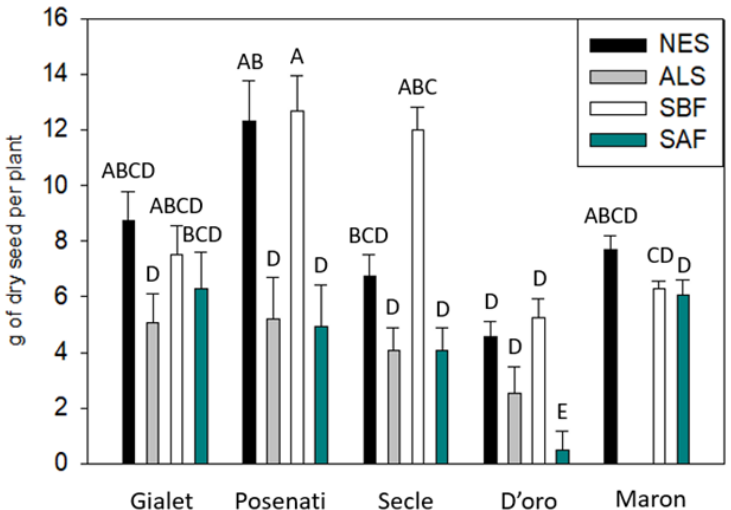
Figure 3. Effects of varieties and treatments interaction on yield (g of dry seeds per plant) of Venetian bean ( P. vulgaris ) local varieties cultivated in a rain-out shelter between March and August 2020. Different letters indicate a significant difference between compared groups. α = 0.05. Treatments were (1) never stressed (NES), (2) always stressed (ALS), (3) stressed before flowering (SBF), and (4) stressed after flowering (SAF). Maron ALS did not produce seeds; thus, it is not represented in the graph. The standard deviation is represented by error bars (n = 4).